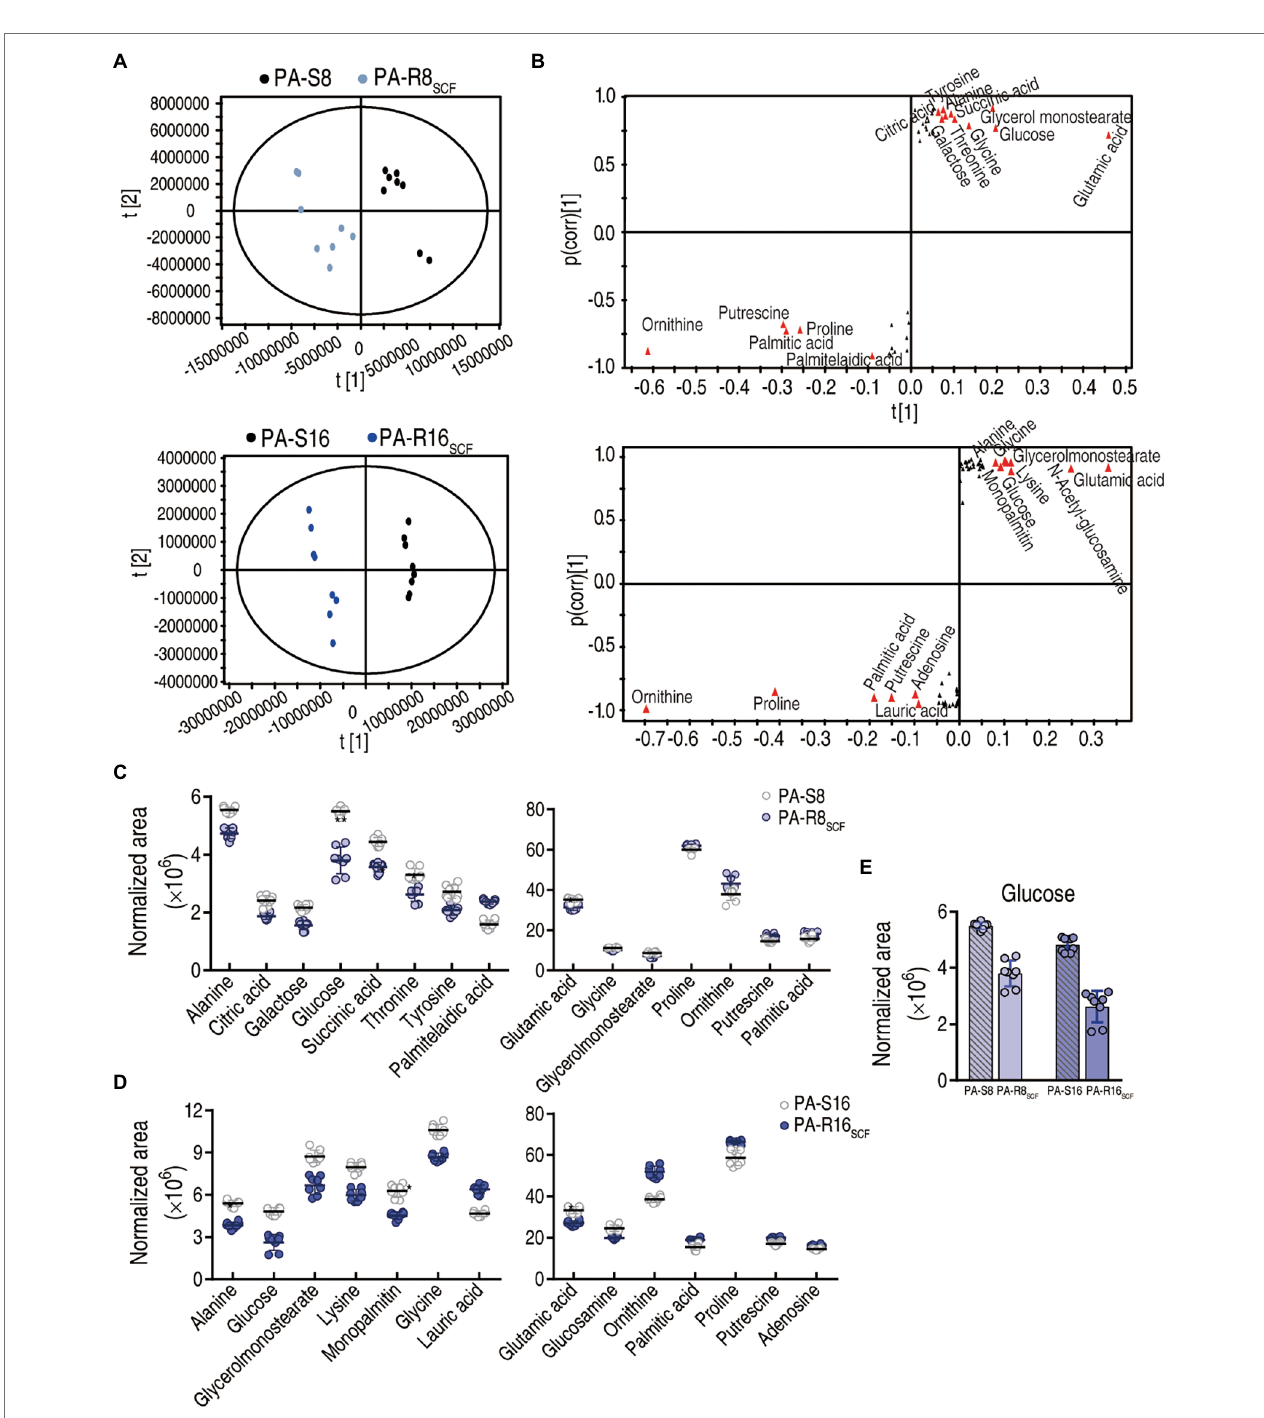
FIGURE 4 | Identification of crucial metabolites. (A) The PCA analysis between PA-R8 SCF , PA-R16 SCF , and PA-S8, PA-S16, respectively. Each dot represents the technique replicates in the plot. (B) S-plot generated from OPLS-DA. Triangle represents individual metabolite, where potential biomarkers are highlighted with red, which is greater or equal to 0.05 and 0.5 for absolute value of covariance p and correlation p(corr), respectively. (C–E) The scatter plot of biomarkers in data (B)